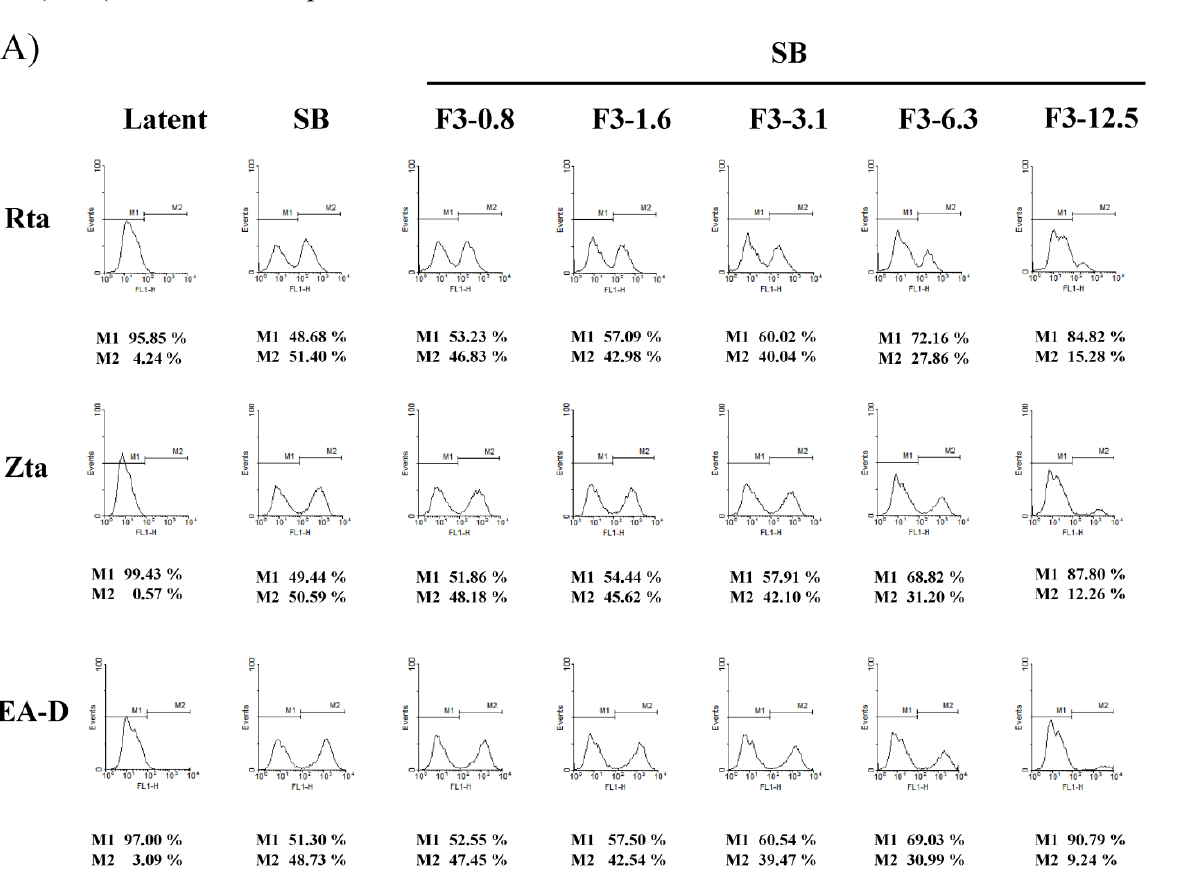
(Figure 5A). For emodin treatment, the P3HR1 cells untreated with SB, the percentages of the cell population expressing Rta, Zta and EA-D were 4.13%, 1.44% and 3.27%, respectively (Figure 5B). The population that expressed the three proteins after SB treatment increased to 54.94%, 59.03% and 57.96%, respectively. When 4.2 μ g/mL of emodin was added before lytic induction, the population that expressed Rta, Zta and EA-D decreased to 23.40%, 30.64% and 28.07%, respectively (Figure 5B). The population that expressed Rta, Zta, and EA-D further decreased when the concentration of emodin was increased to 8.5 μ g/mL. At 8.5 μ g/mL, the population that expressed Rta, Zta, and EA-D decreased to 7.32%, 2.91%, and 5.53%, respectively (Figure 5B). These results showed that F3 and emodin inhibited the expression of Rta, Zta and EA-D in a dose-dependent manner (Figure 5C,D). Figure 5. Inhibition effects of F3 and emodin on the number of cells expressing EBV lytic proteins by flow cytometric analysis. Various concentrations of F3 (0.8, 1.6, 3.1, 6.3 and 12.5 μ g/mL) or emodin (Em) (1.1, 2.1, 4.2, 8.5 μ g/mL) pre-treated P3HR1 cells, then